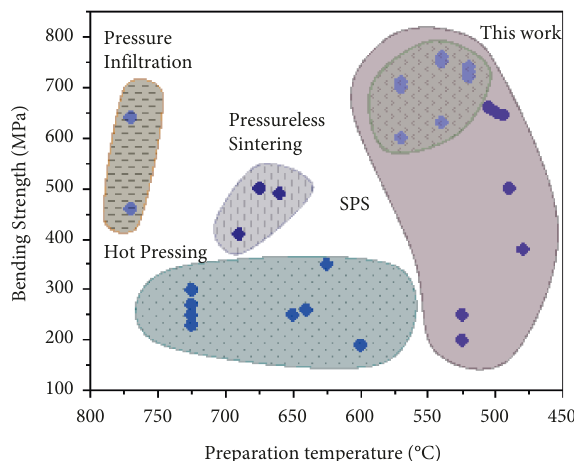
Figure 3: A comparison between WC/Al composite bending strength and temperature